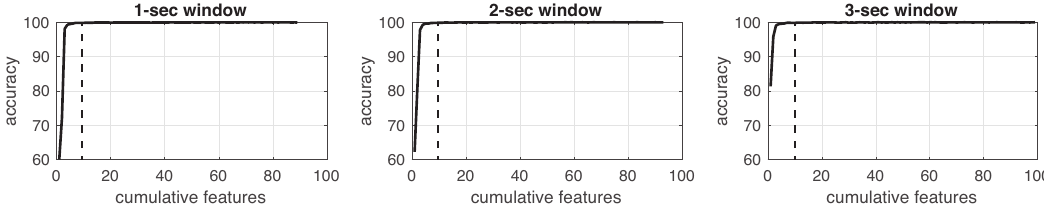
Figure 11. Accuracy performance on training using cumulative features for Experiment 4 : IR + IMU + EEG. From left to right, it presents the performance using: 1-second length windowing, 2-second length windowing and 3-second length windowing. The dash line reports the number of cumulative features employed for the next